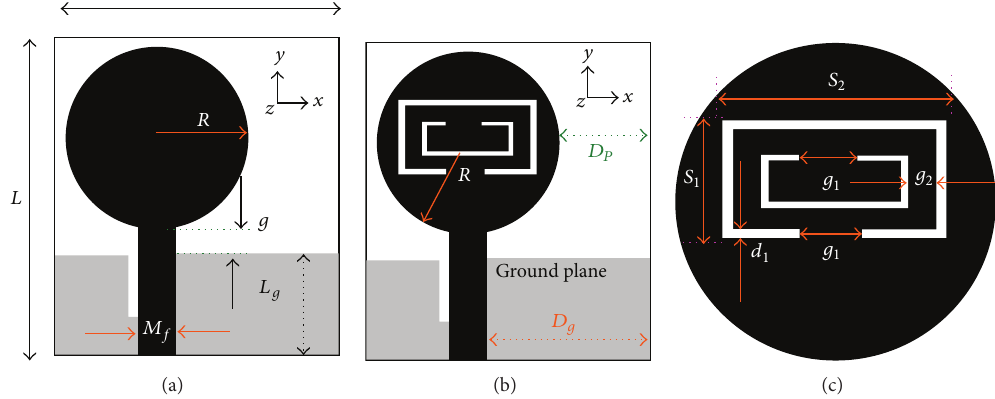
Figure 1: Structures of the (a) UWB antenna, (b) proposed band-rejected antenna, and (c) band-rejection layout.